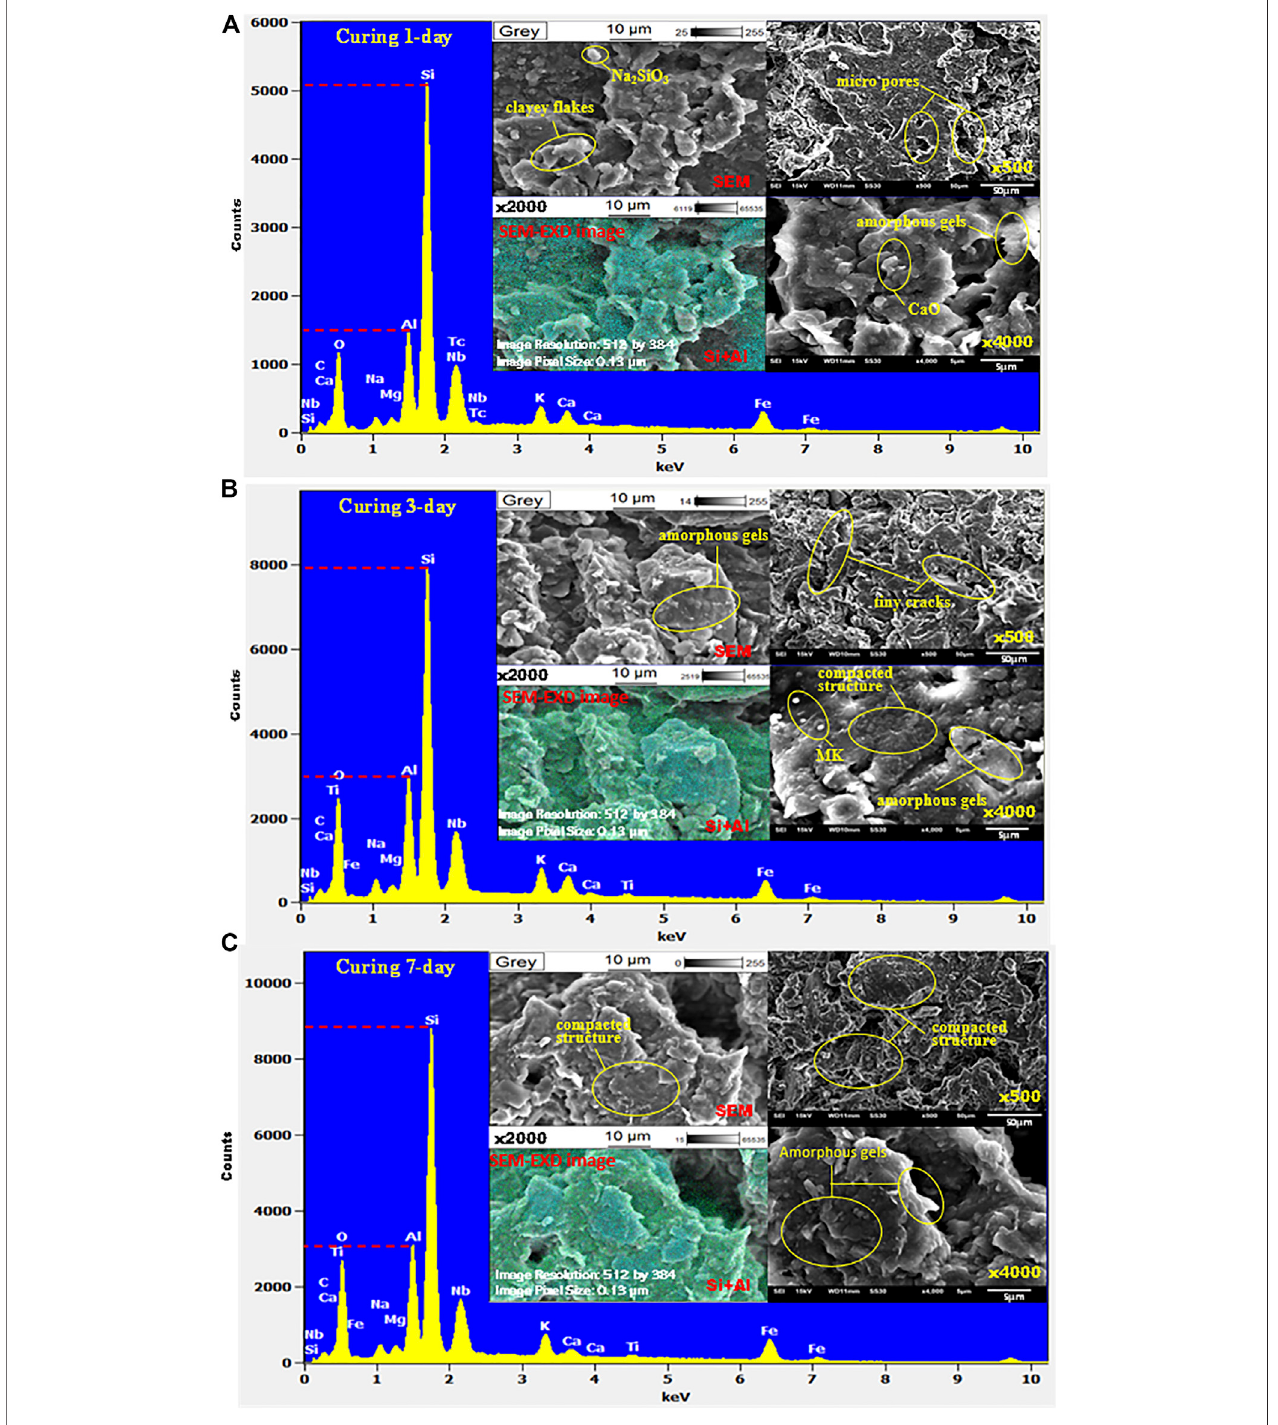
FIGURE 3 | SEM images and EDX analyses of GSC specimens after 1 day, 3 days, and 7 days.